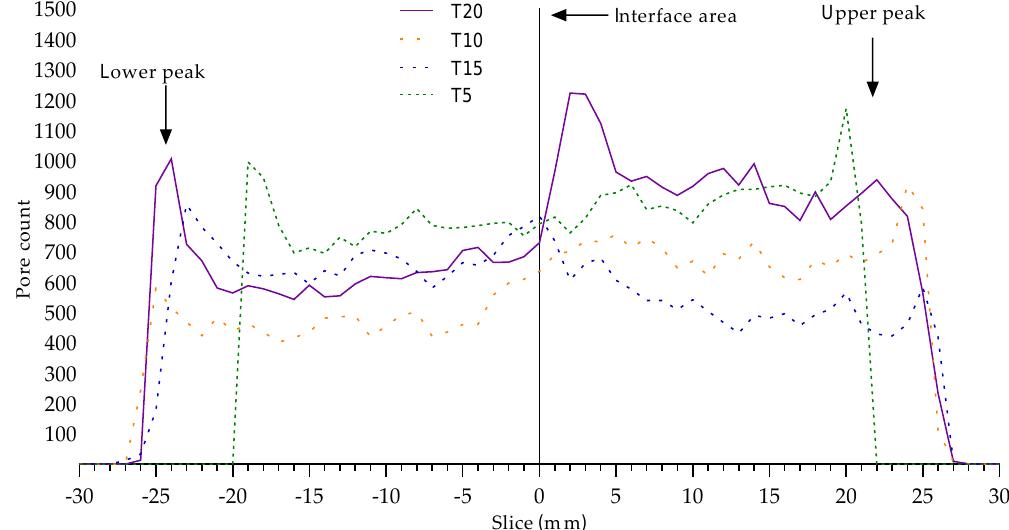
Figure 13. Qualitatively different pore distribution trends related to the moisture exchange phenomena; note, e.g., the symmetric peak locations of T5 vs. T20.